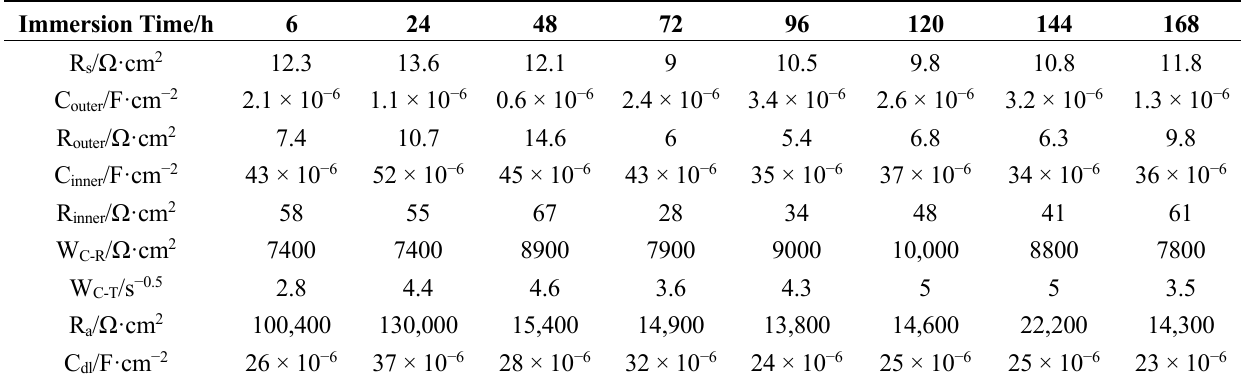
Table 2. Best fit results for equivalent circuit elements at applied current density of 150 mA·m − 2 .